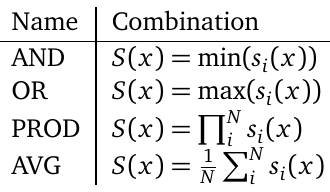
Table 4: The four algorithms used to combine N anomaly scores s anomaly score S .